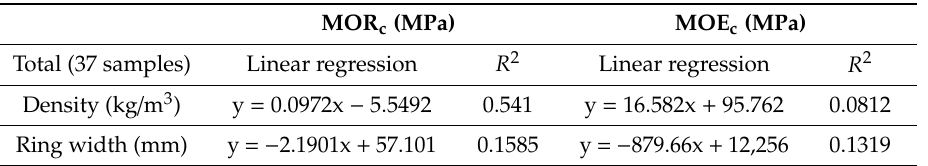
Table 4. Summary of the linear regression and quadratic